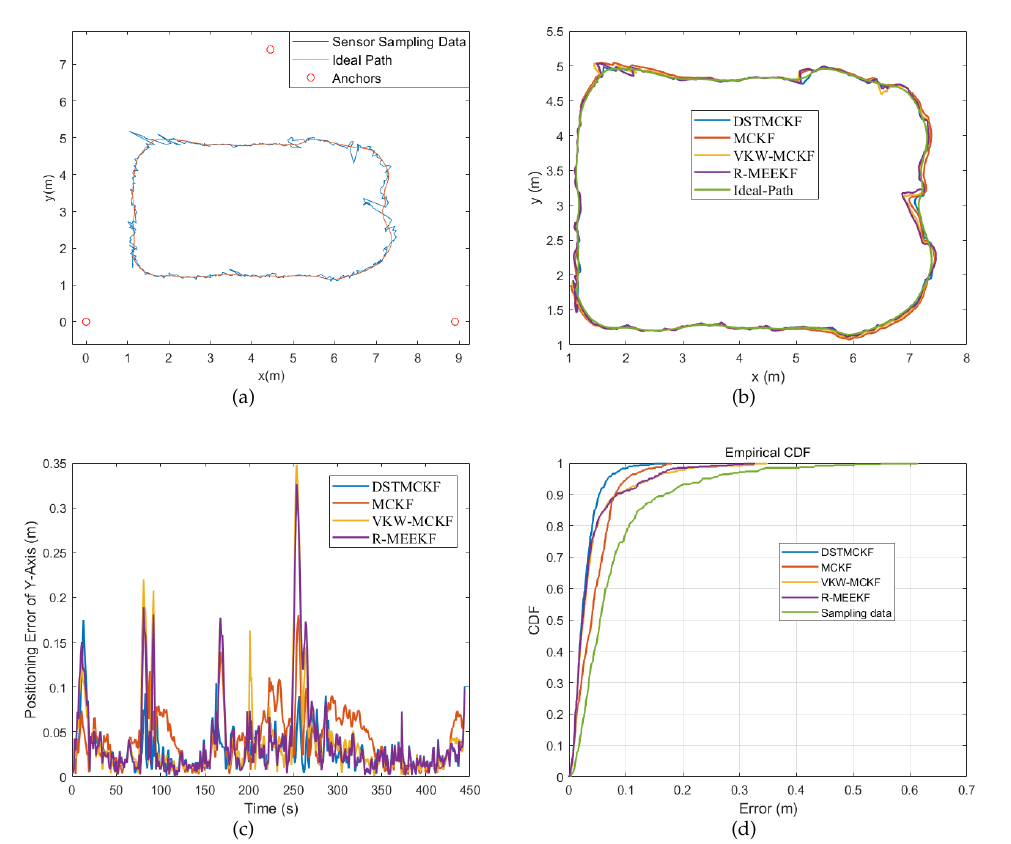
Figure 11. Results in real world. ( a ) Sampling results in real world; ( b ) filtering results in real world; ( c ) filtering error in real world; ( d ) CDF of each